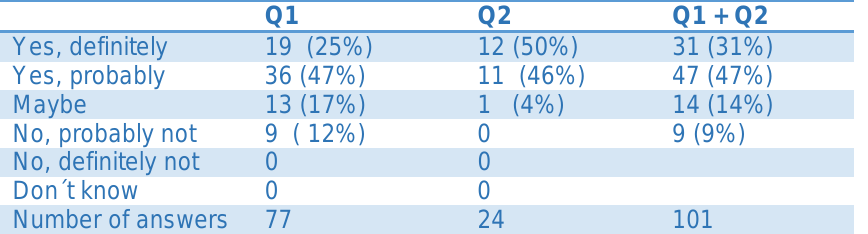
Table 5: Statement. Cost overruns would be considerably less if the client put more resources into technical investigations early in the project